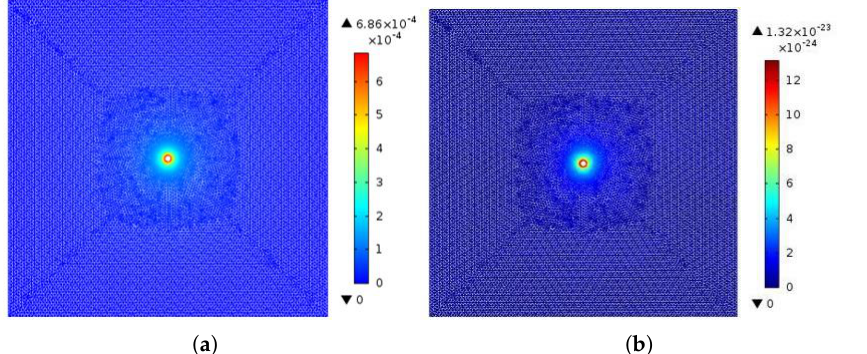
Figure 9. Two-dimensional steady-state poroelasticity simulation with COMSOL. ( a ) Total rock displacement (m) and ( b ) pore-fluid velocity (m/s).